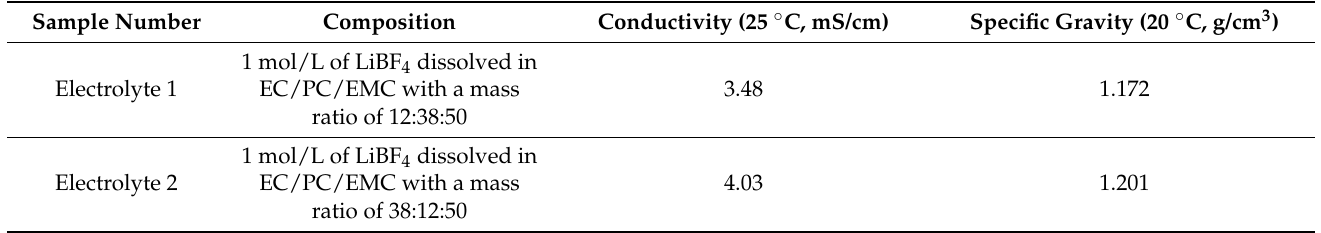
Table 2. Composition and parameters of the two electrolytes in this paper. Sample Number Composition Electrolyte